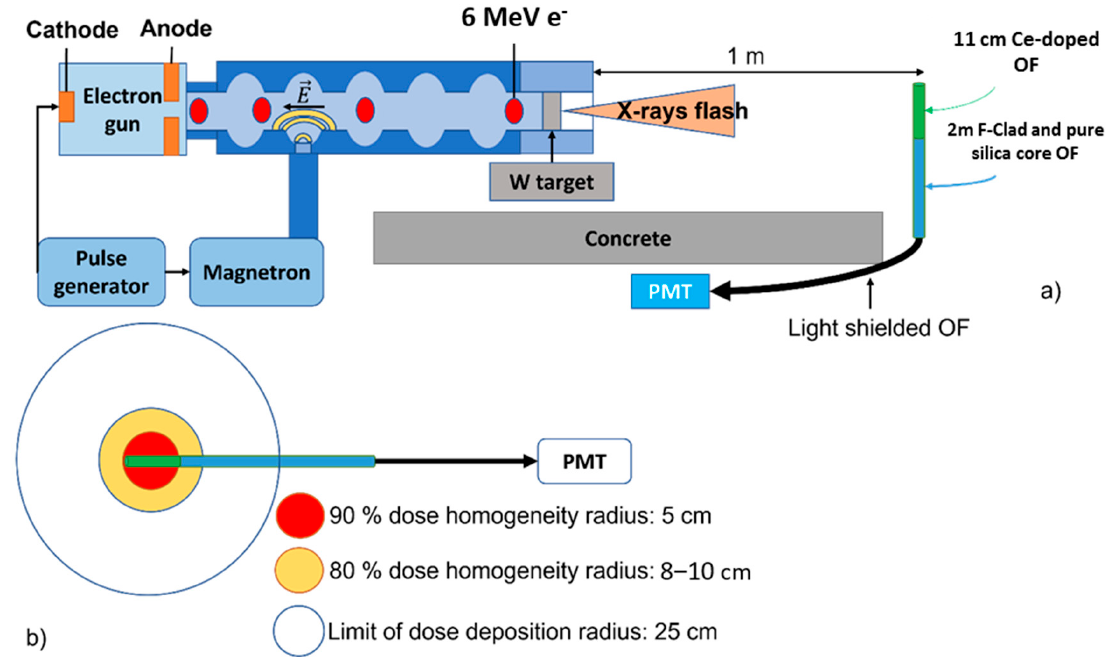
Figure 5. (a ) Accelerator and setup scheme. ( b ) Schematic representation of the dose deposition by the ORIATRON X-ray beam and positioning of the optical fiber sensing probe in front of the beam.